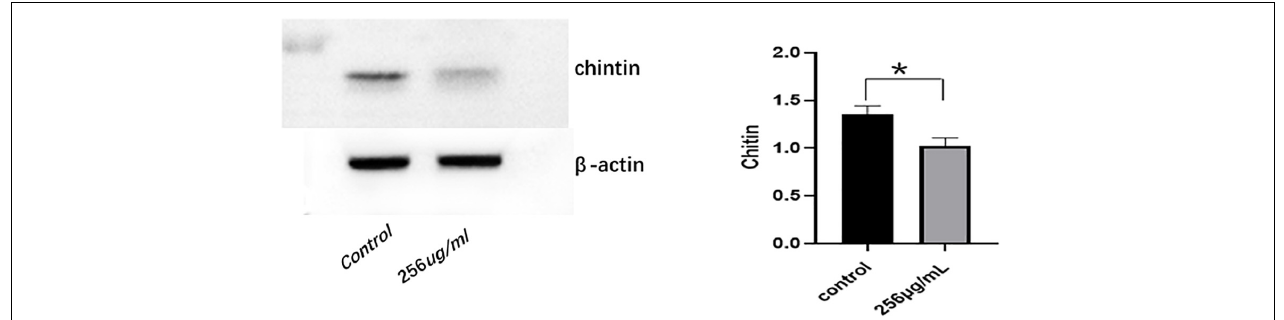
FIGURE 8 | The expression level of chitin synthase (CHS) protein detected by Western blot (* P < 0.05).